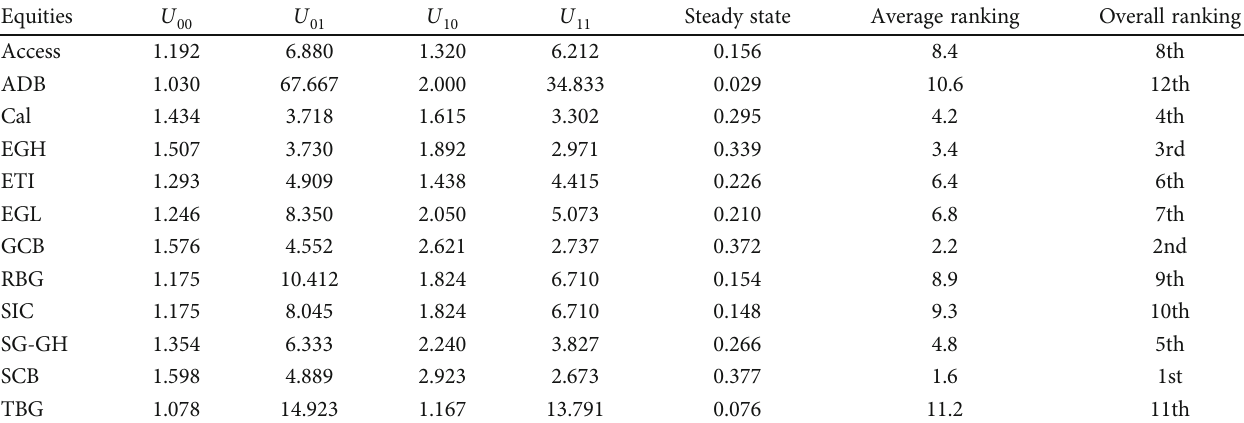
Table 4: The rankings of the equities based on their mean recurrent times and steady state.